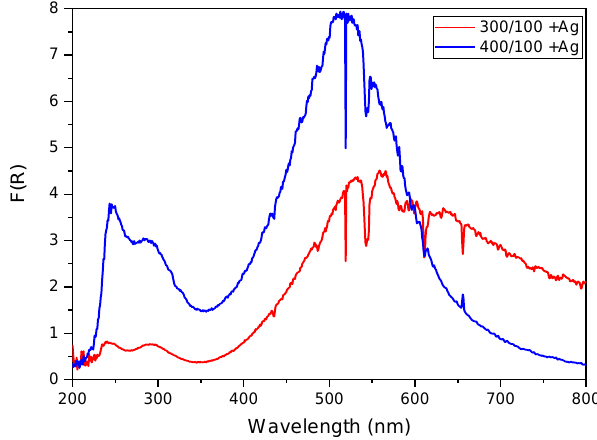
Figure 10. Kubelka – Munk absorbance function F(R) vs wavelength for heat-treated TiO x catalysts coated with Ag.